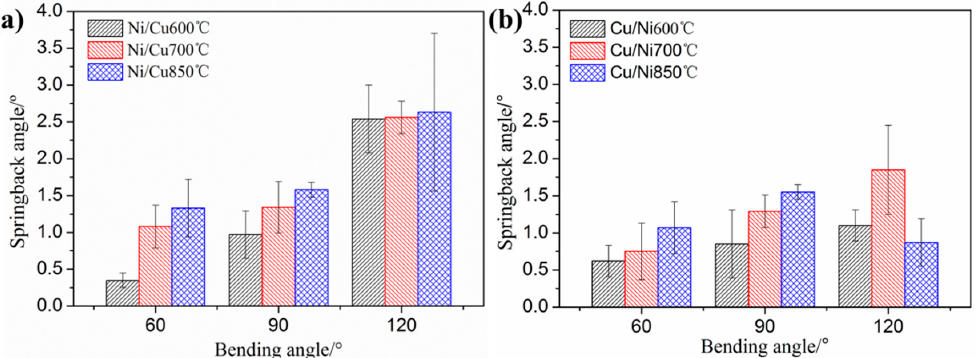
ff erent bending angles ( a ) Ni / Cu and ( b ) Cu /